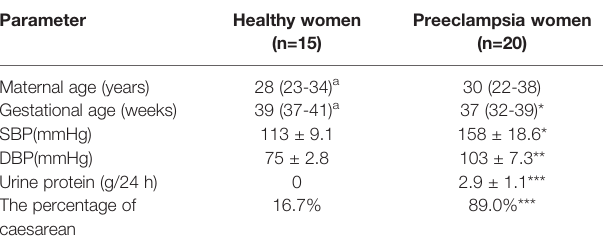
TABLE 1 | Demographic and biophysical characteristics of the clinical study